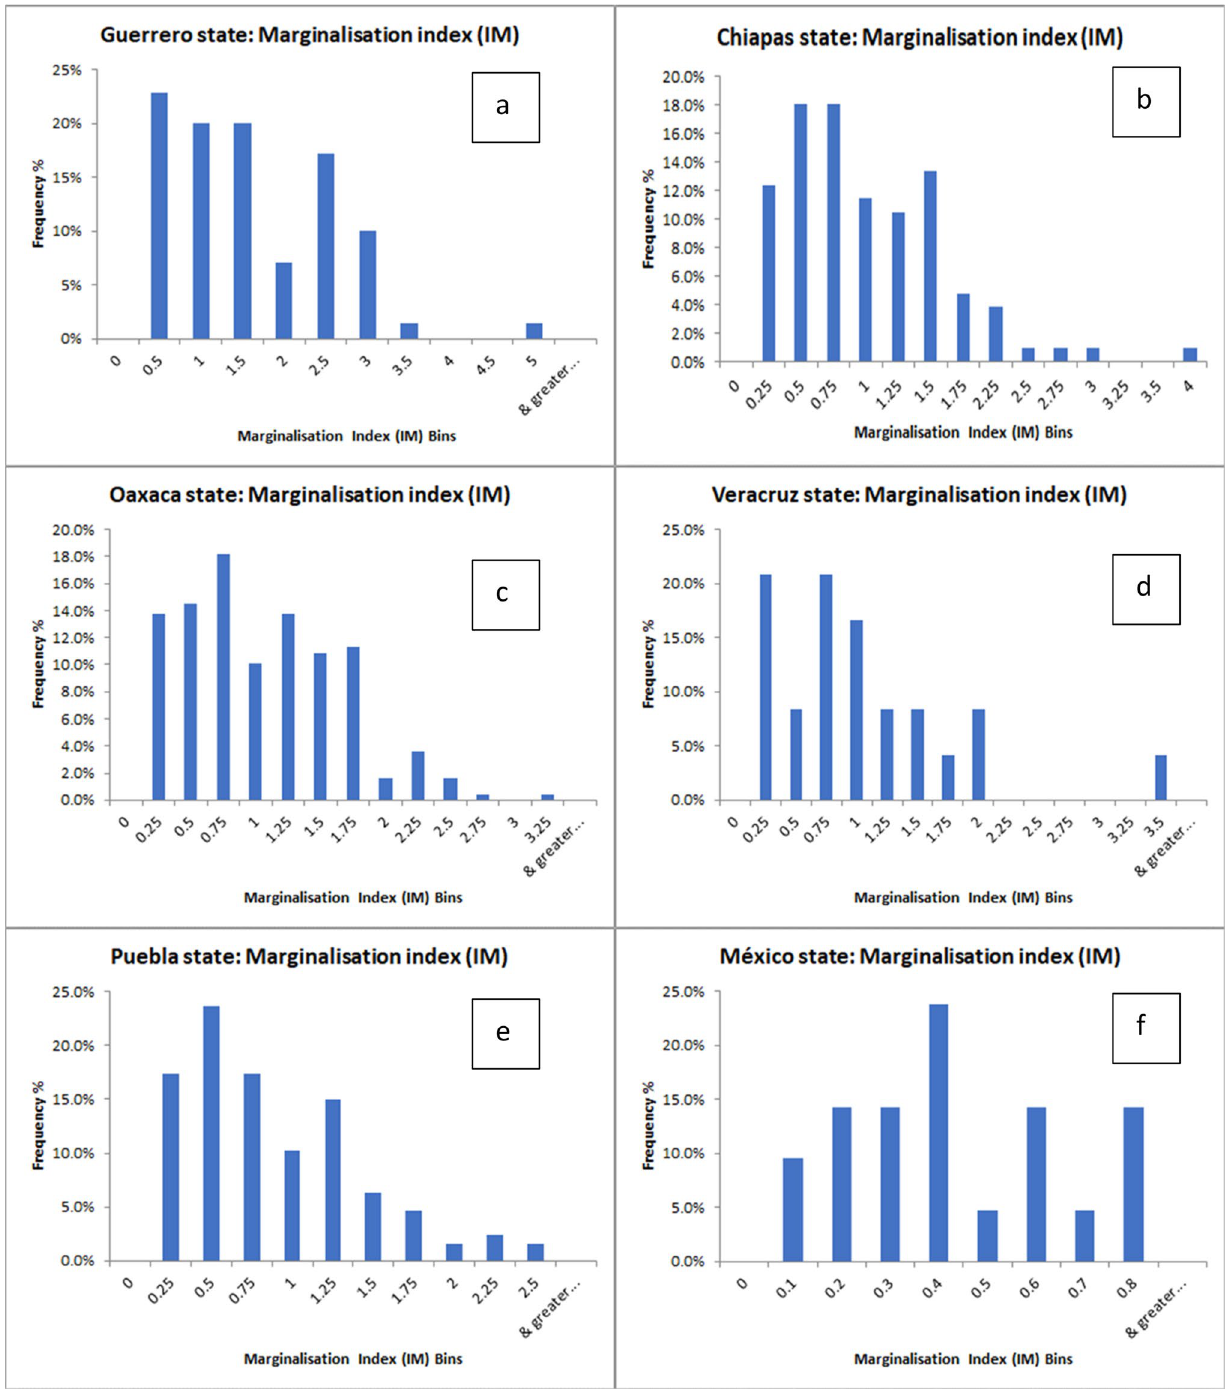
Fig. 12 Histogram for Marginalisation Index (IM) for municipalities with IM > 0 in several states. Weighted IM: a Guerrero [1.05], b Chiapas [1.06], c Oaxaca [1.05], d Veracruz [1.03], e Puebla [0.88], f México